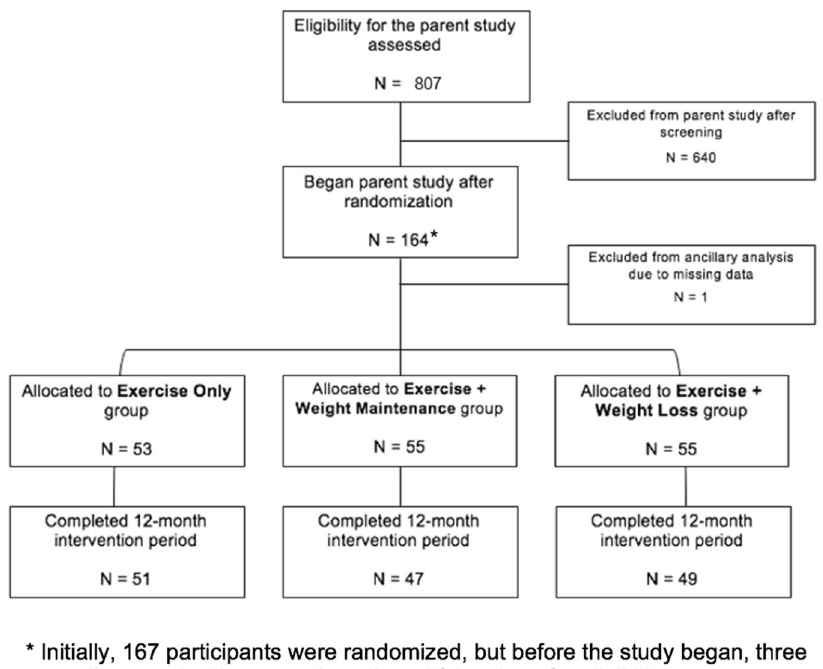
Fig. 1 Flow Diagram for Study Inclusion. Recruitment, randomization, and allocation of a 12-month exercise and diet intervention conducted among older adults with ( F (2,157) = 4.44, p = 0.013). Among the total sample and by